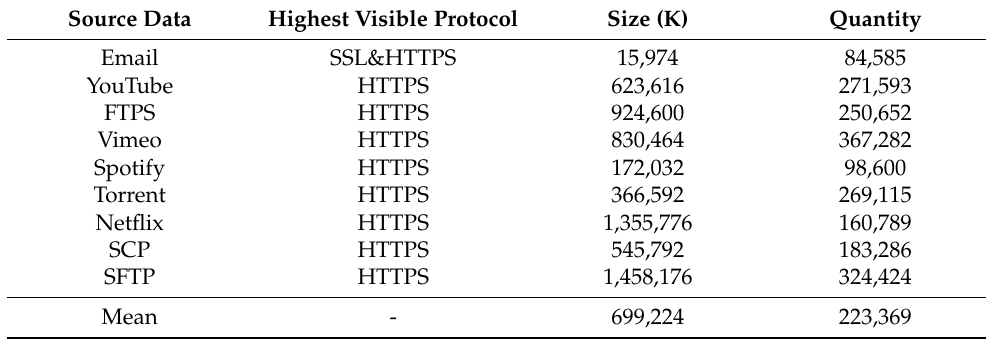
Table 1. Source dataset details.